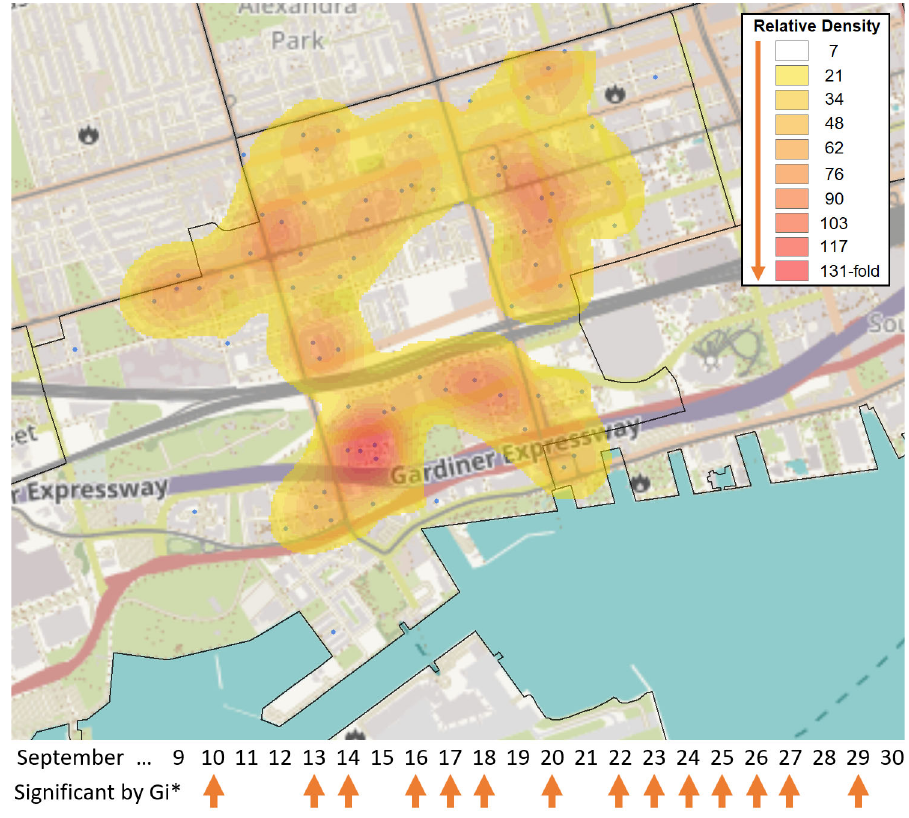
Figure 4. Broad distribution of COVID-19 cases across FSA M5V in Toronto. The FSA M5V in the entertainment district of Toronto was identified as ahotspot relative totherest of Ontarioby theGi* test over 14 days in September 2020 (case counts ≥ 6, with five days exhibiting at least 10 cases [Sept. 10 th , 13 th , 20 th , 22 nd , 23 rd ]). These cases were distributed across 71 separate PCs in M5V. A heat map generated with the Kernel Density function within the Spatial Analyst Toolbox of ArcGIS shows the relative density of postal codes with cases (blue dots), weighted by the number of days in which each individual postal code had ≥ 1 case (N = 118 cases total). Kriging analysis did not identify localized hotspots during this period, as none of the PCs exceeded 3